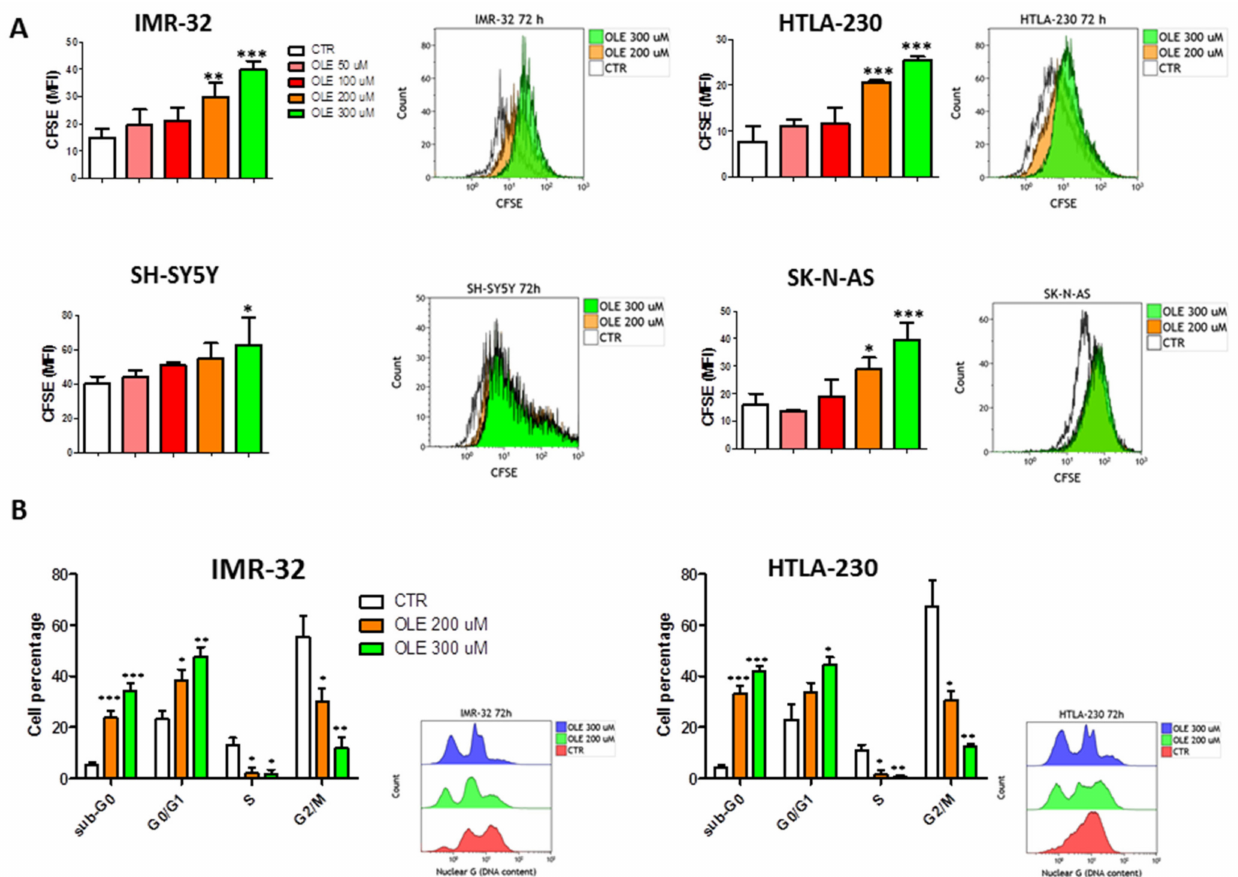
Figure 4. Inhibition of cell proliferation, through a G0/G1 cell cycle arrest, mediated by OLE treatment. ( A ) The green fluorescence intensity of Carboxyfluorescein Succinimidyl Ester (CFSE) was recorded by FCM. According to the dilution of the dye, more fluorescence means less proliferation. Insets show representative FCM experiments of CFSE assay. ( B ) Cell cycle progression of IMR-32 and HTLA-230 determined by Nuclear Green labeling. Insets show representative cell cycle progression assay, analyzed by FCM. Data are expressed as mean ± SD of three independent experiments (* p < 0.05, ** p < 0.01, *** p < 0.001 vs. CTR). CTR: control; OLE: olive leaf extract; uM: micromolar; MFI: mean fluorescence